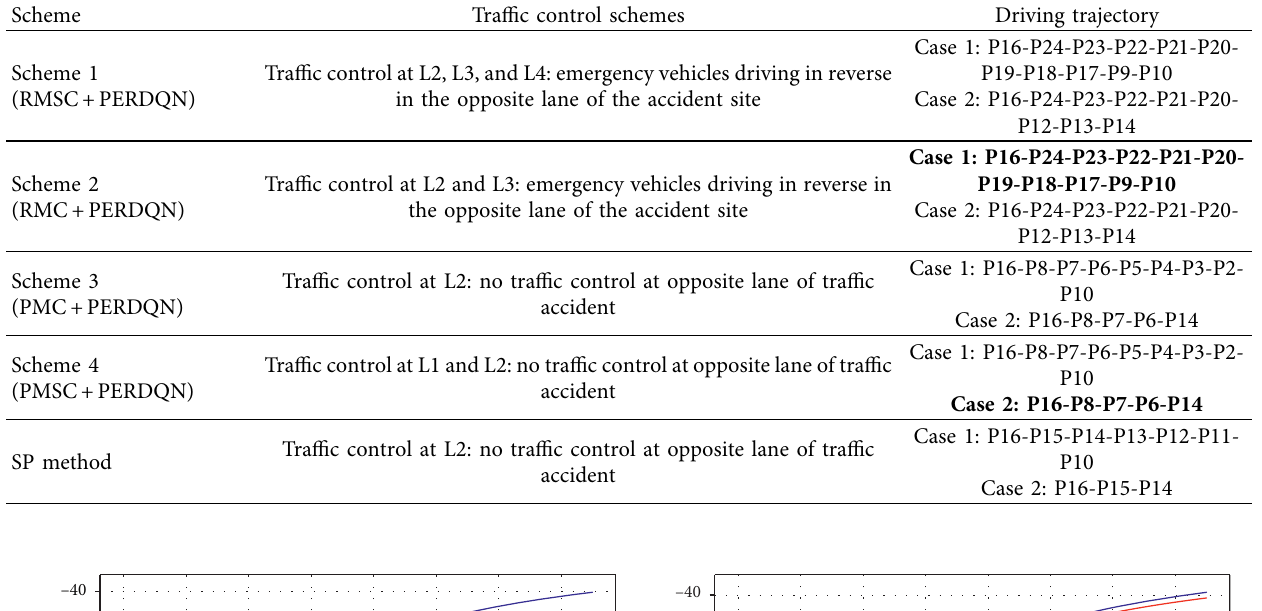
Table 3: Three typical schemes for emergency vehicle route planning on East Youyi Road.